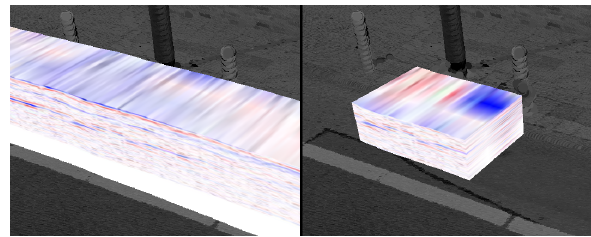
Figure 4. Cuboid rendered onto the GPS trajectory (left). Vertical and horizontal slicing can be used to explore data inside the cuboid (right).